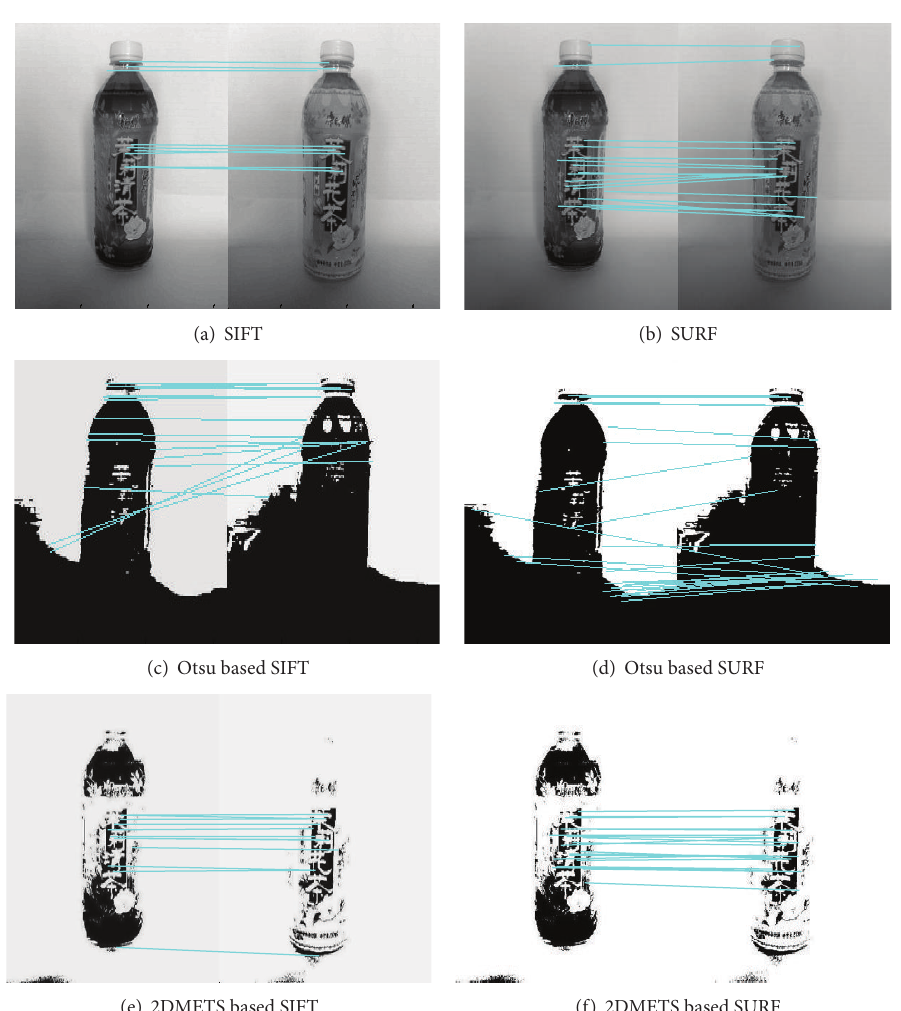
Figure 6: Target matching for images in group